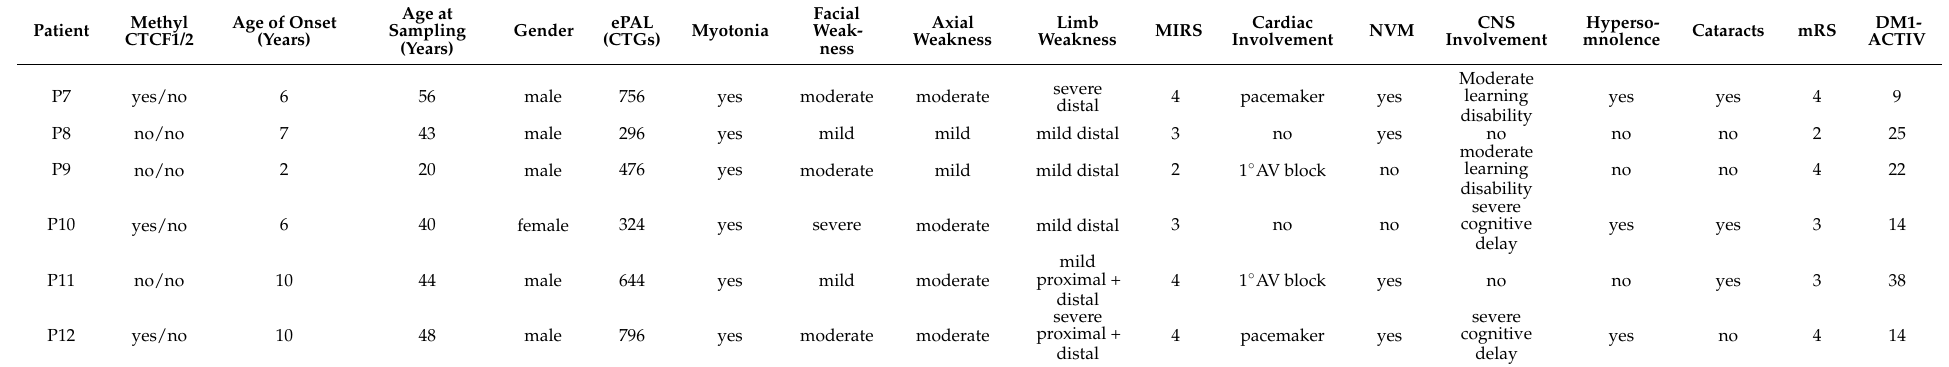
Table 3. Clinical characteristics of childhood